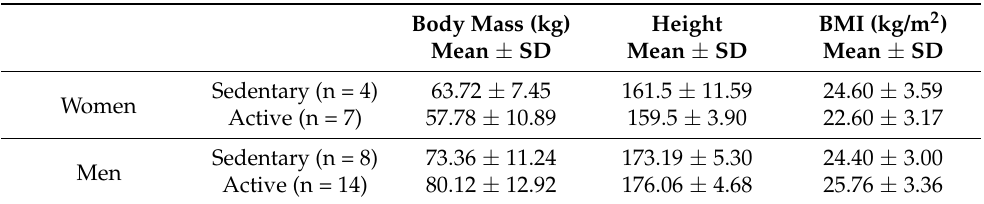
Table 1. Results of the anthropometric characteristics of young men and women who underwent the maximum stress test on a treadmill.